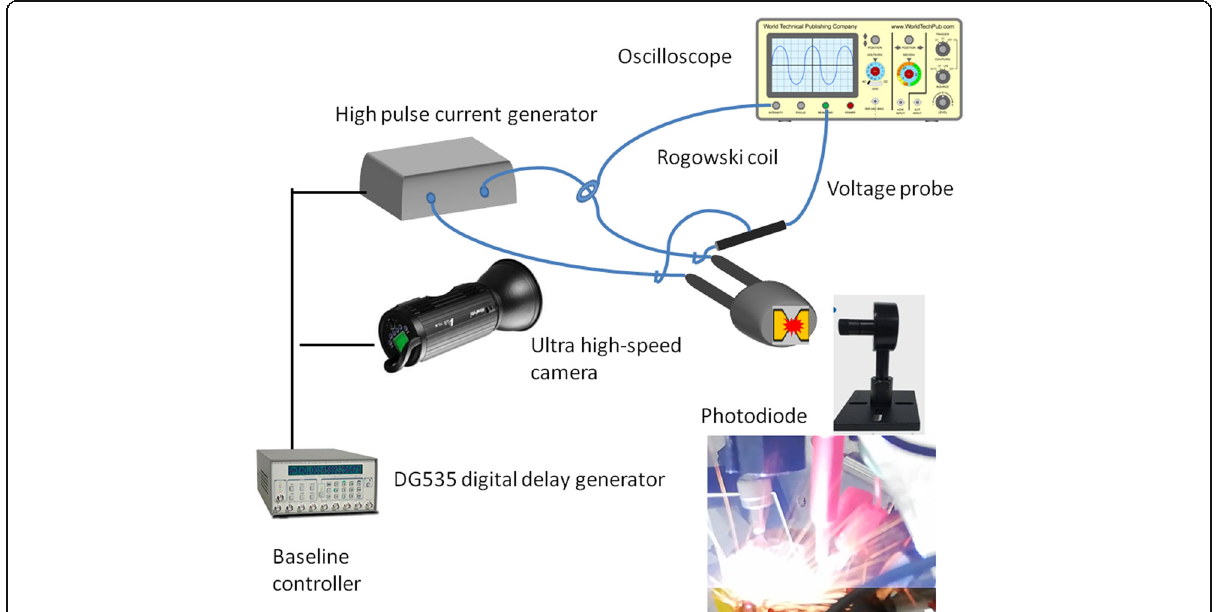
Fig. 2 Testing schematic drawing of the micro-plasma generator